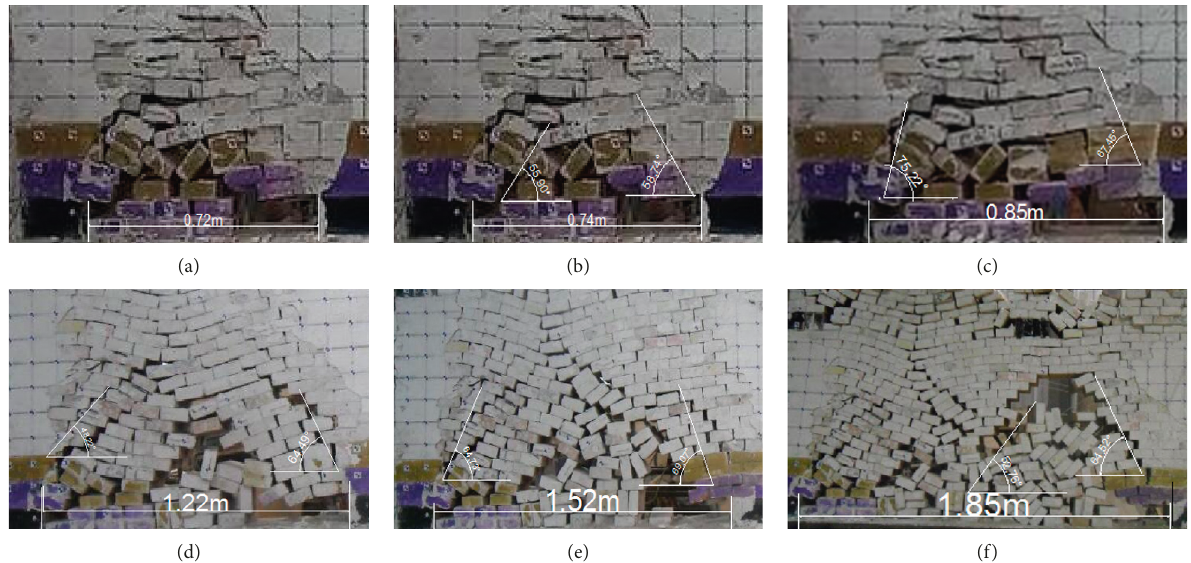
Figure 2: The advancing distance of theworking face and strata pressure phenomenon of stope in 80cm (40m) interlayer. (a) 1st topcoal caving. (b) 1st roof caving. (c) 1st roof weighting pace. (d) 1st periodic roof weighting. (e) 2nd periodic roof weighting. (f) 3rd periodic roof weighting.